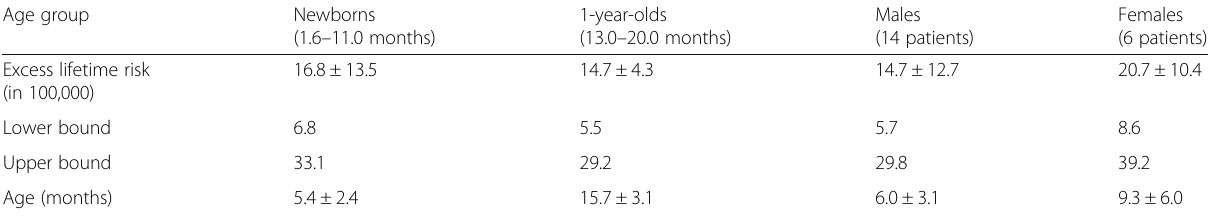
Table 3 Age- and gender-dependent mean excess lifetime risk (chances in 100,000 persons) Age group